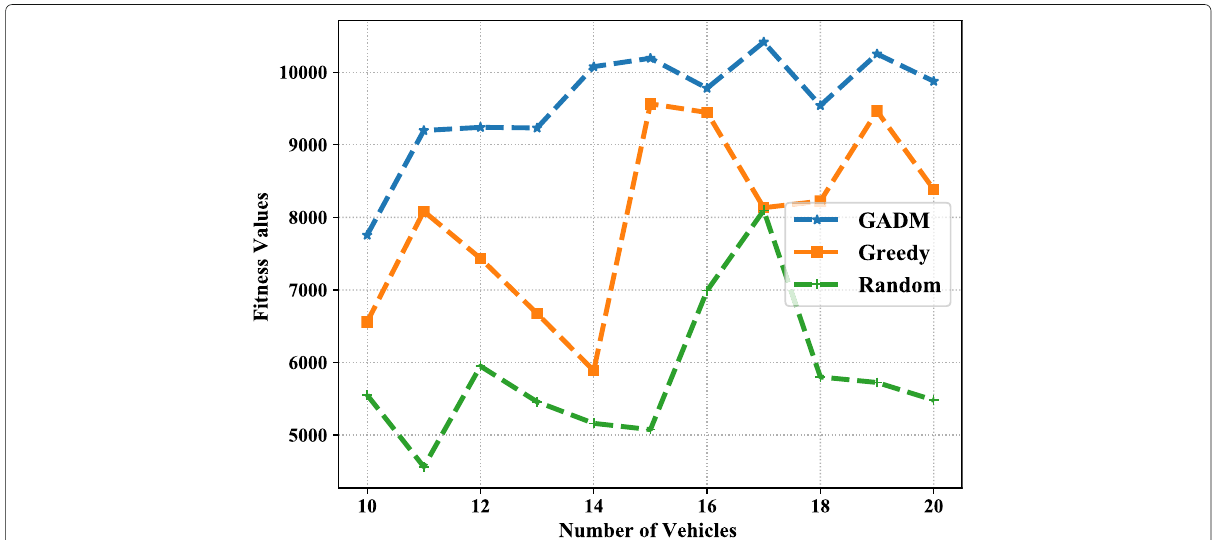
Fig. 10 Fitness values with different number of vehicles (small)